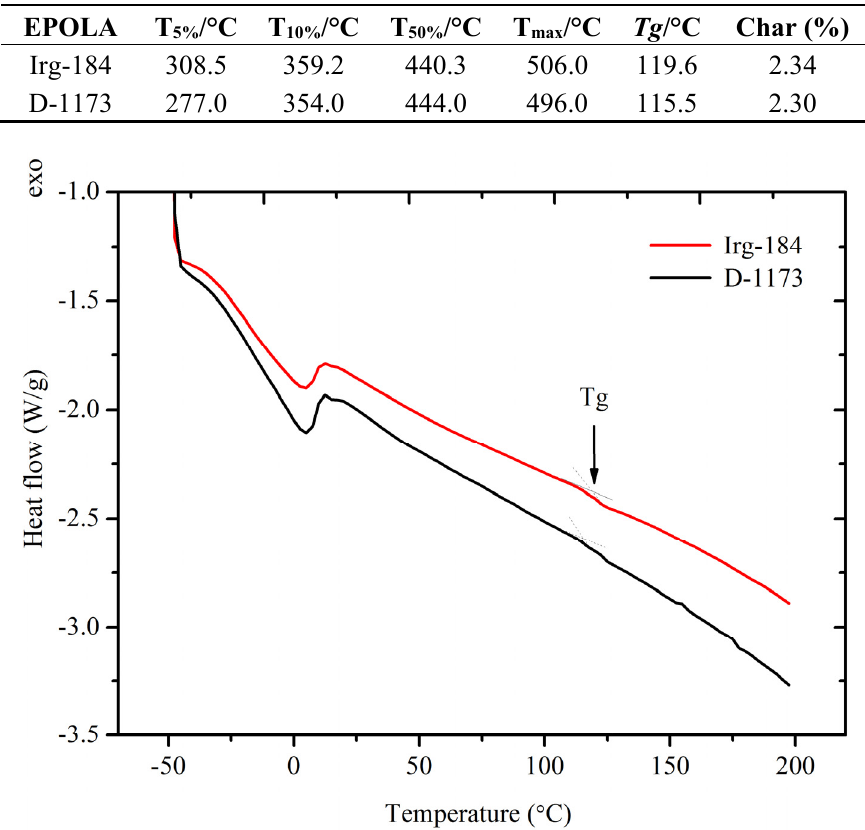
Table 4. Thermal data of EPOLA Films Containing Irg-184 and D-1173 Photoinitiators.